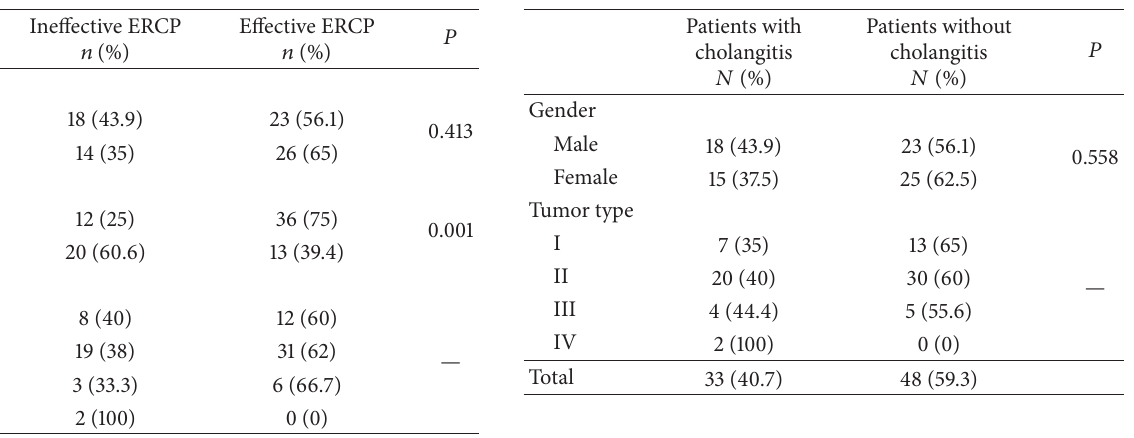
Table 1: Distribution of patients with respect to gender, develop- ment of cholangitis, and tumor type by ERCP effectiveness.